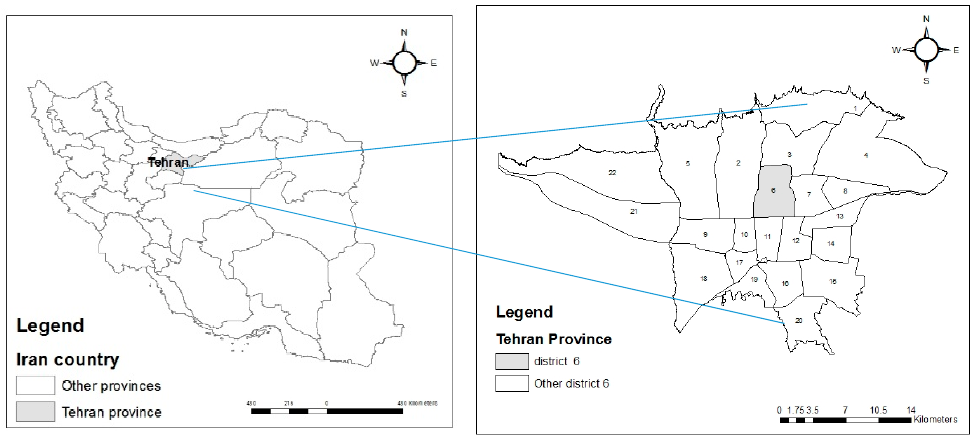
Figure 4. The geographical position of the study area.